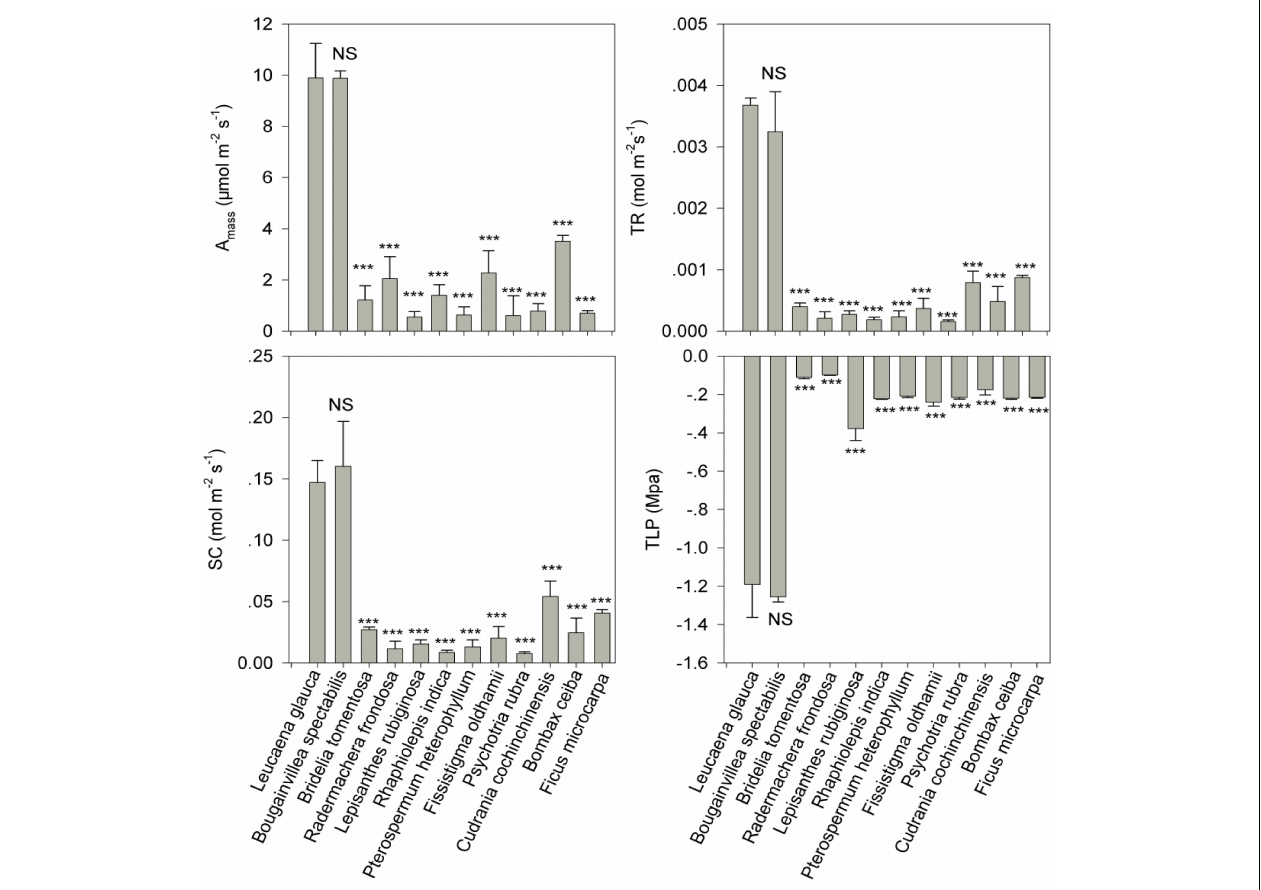
FIGURE 3 | Differences in the four functional traits (i.e., transpiration rate, TR; maximum Photosynthesis rate, Amass; stomatal conductance, SC; and leaf turgor loss point, TLP) between the invasive exotic plant species L. leucocephala , and each of the 11 native plant species (i.e., B. spectabilis, B. ceiba and F. microcarpa, B. tomentosa, R. frondosa, L. rubiginosa, R. indica, P. heterophyllum, F. oldhamii, P. rubra, and C. cochinchinensi ). *** indicates P < 0.05 and NS (short for non-significant) indicates P > 0.05 based on Wilcoxon signed-rank